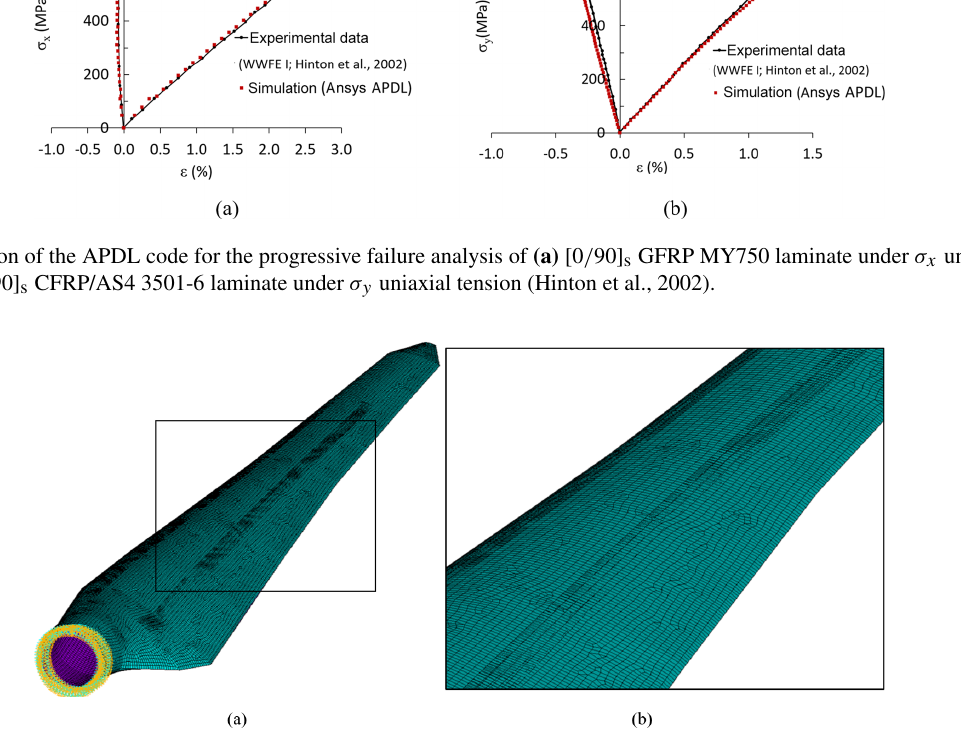
Figure 5. (a) Boundary conditions and the mesh density of the FE model and (b) blade